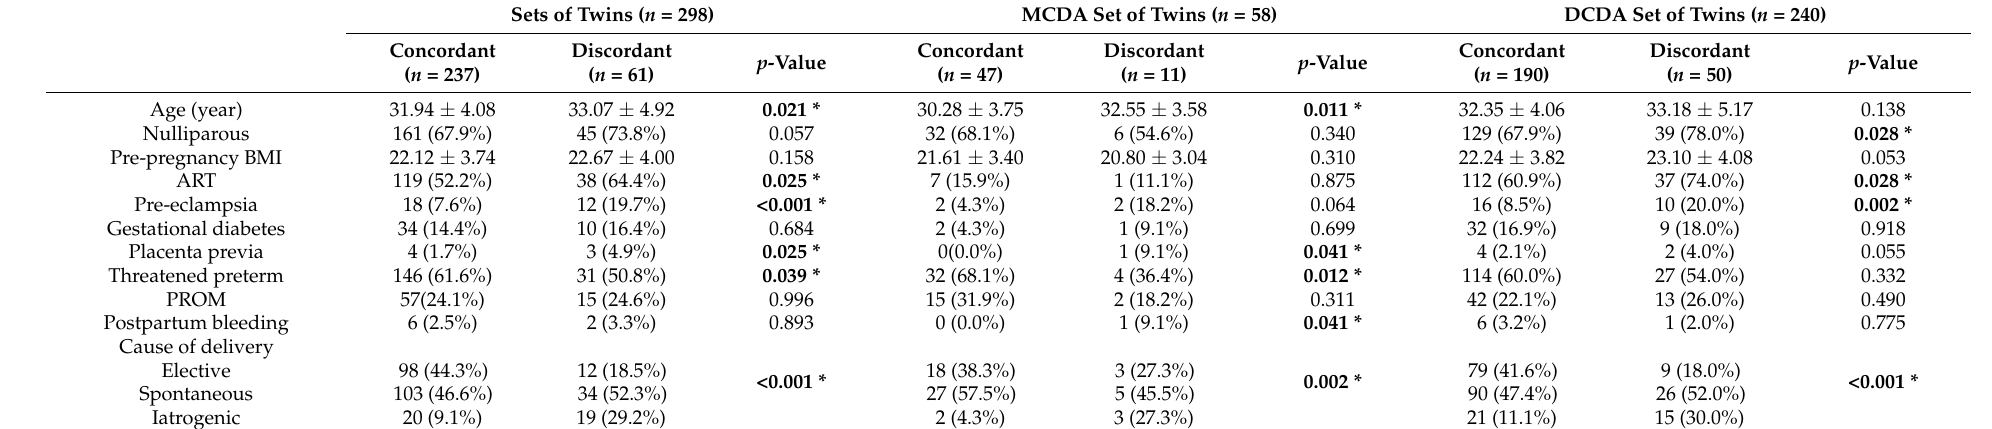
Table 1. Maternal characteristics and obstetrical complications in concordant and discordant twins according to chorionicity.